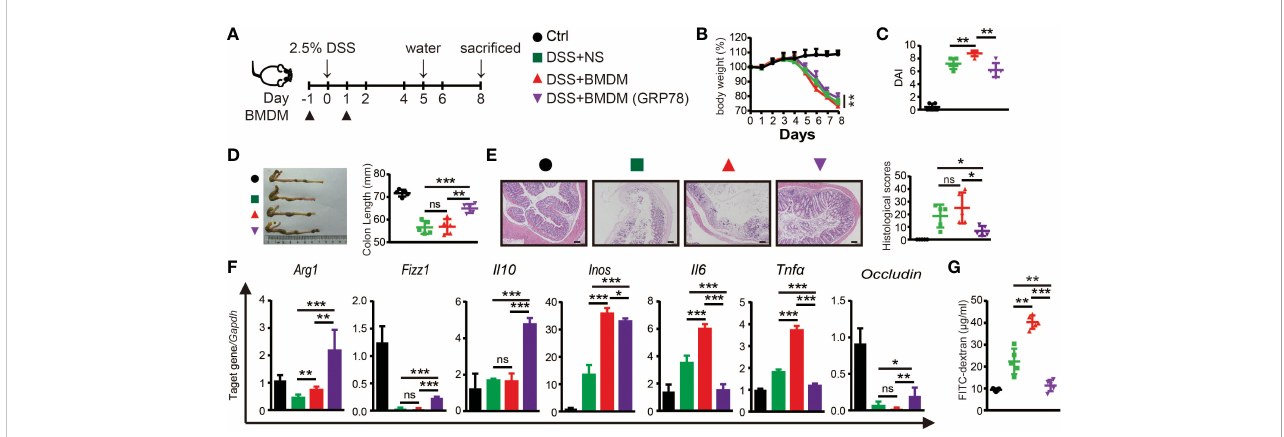
FIGURE 6 Adoptive transfer of sGRP78-conditioned BMDMs ameliorated DSS-induced colitis. (A) Timetable scheme showing DSS and BMDMs administration in mice. Effect of sGRP78-induced BMDMs on (B) weight loss, (C) DAI score (n=5) in DSS exposed mice. (D) Representative gross picture of colons (left) and quanti fi cation of colon length (right). (E) Representative HE-staining (left) and respective colitis scores of indicated groups (right). Scale bar: 100 m m. (F) mRNA expression of Arg1, Fizz1,Il10, Inos, Il6, Tnf a , Occludin in colonic tissues. (G) FITC-dextran concentrations in serum of mice. (Ctrl group: black circle; DSS+NS group: green square; DSS+BMDMs group: red regular triangle; DSS+BMDMs (GRP78) group: Purple inverted triangle). Data represent mean ± SEM (n=4-5). ns, not signi fi cant. * p < 0.05, ** p < 0.01, *** p <